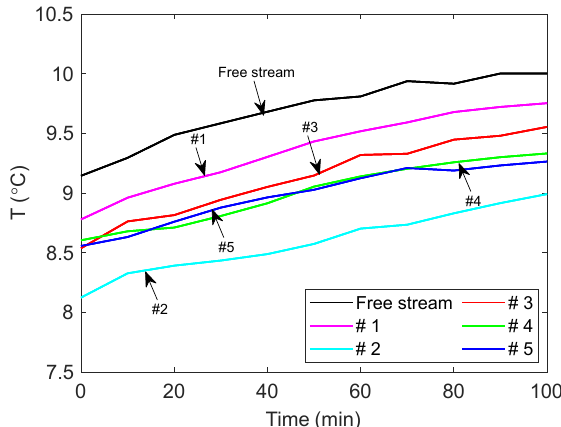
Figure 6. Free stream temperature and temperatures at locations inside the enclosure for Test Condition 3.